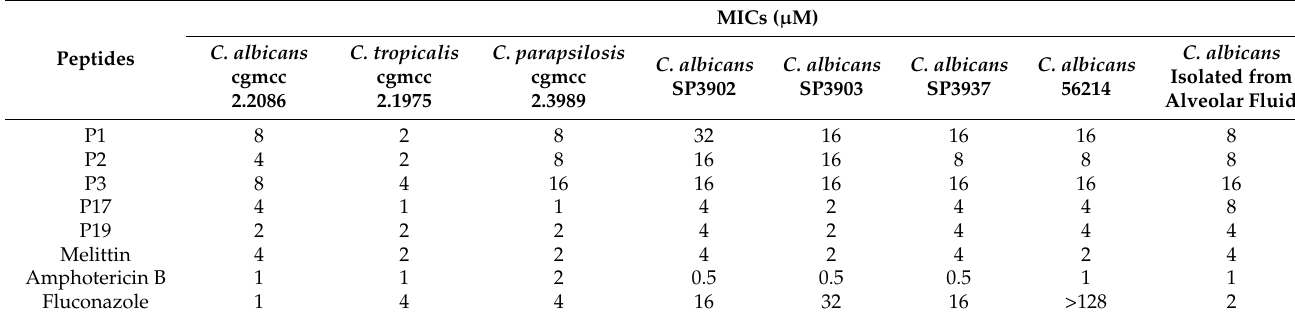
Table 3. The MICs of the peptides against fungi.